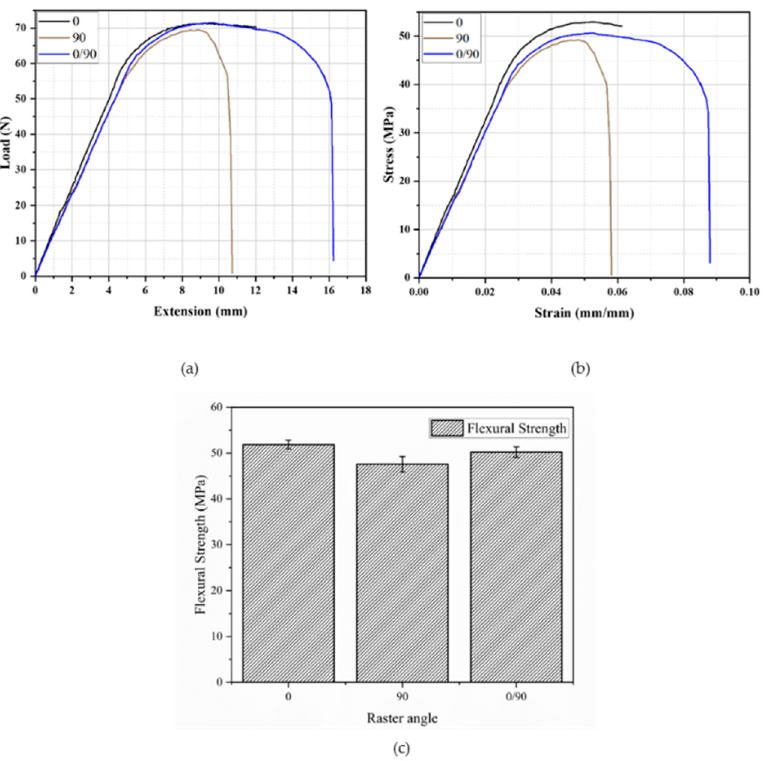
Figure 9. ( a ) Edgewise load extension and ( b ) edgewise stress–strain behavior for different raster angles; ( c ) comparison of edgewise flexural strength for different raster angles. Table 3. Experimental results for edgewise flexural